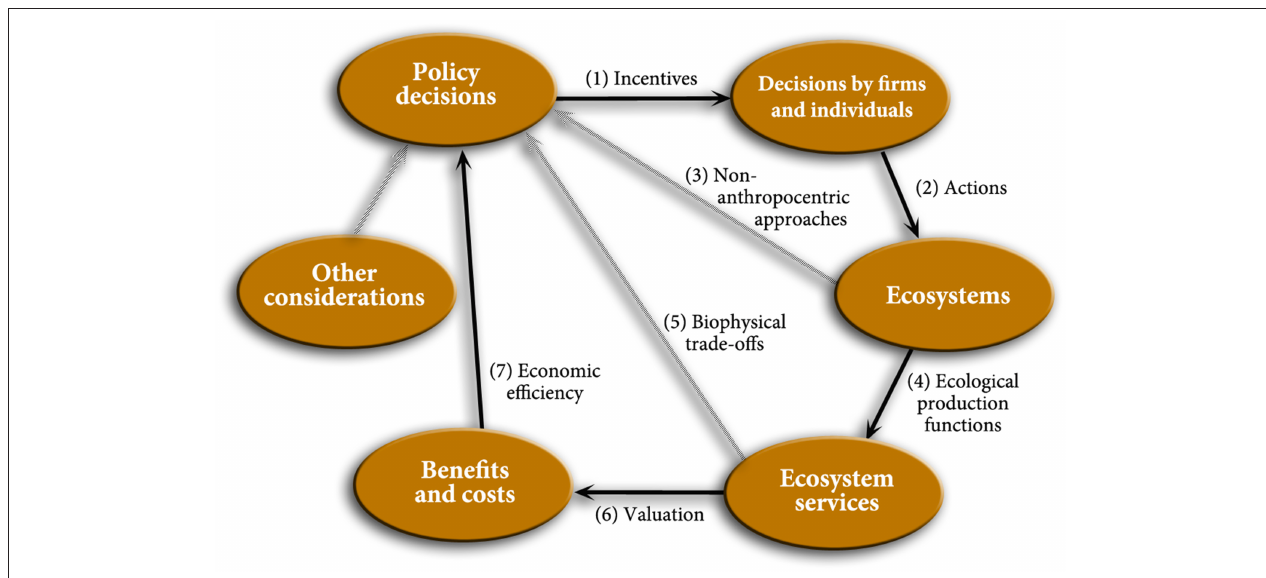
FIGURE 7 | Framework for integrating economics and ecology in the study of ecosystem services. Solid lines indicate the links where the integration of the two disciplines can play an active role (Modified from Polasky and Segerson,